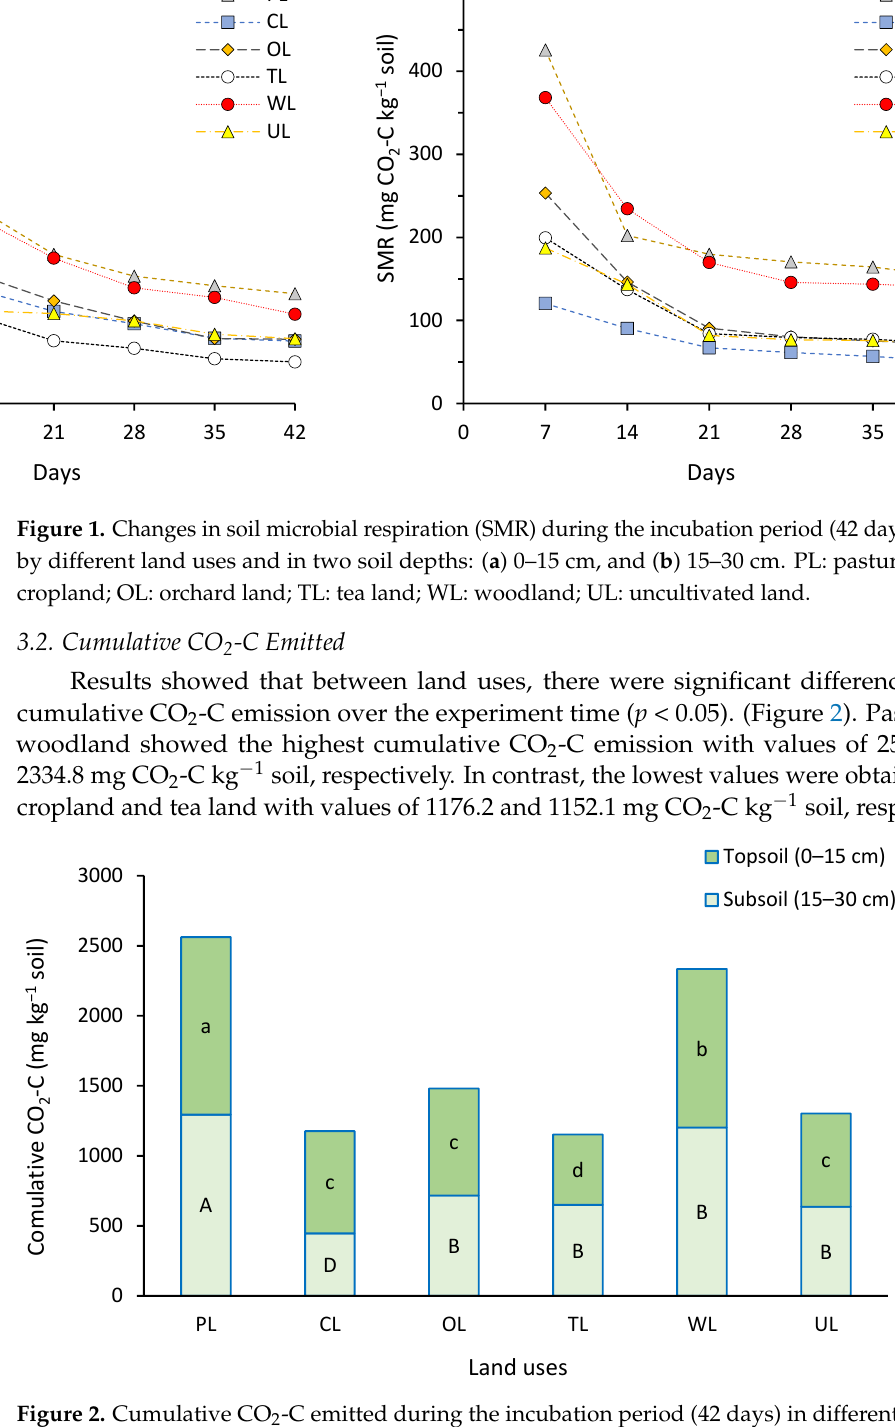
Figure 2. Cumulative CO 2 -C emitted during the incubation period (42 days) in different land uses and two depths. Similar small letters refer to no significant difference between land uses in topsoil (0 – 15 cm), and similar capital letters refer to no significant difference between land uses in subsoil (15 – 30 cm). PL: pastureland; CL: cropland; OL: orchard land; TL: tea land; WL: woodland; UL: uncultivated land.